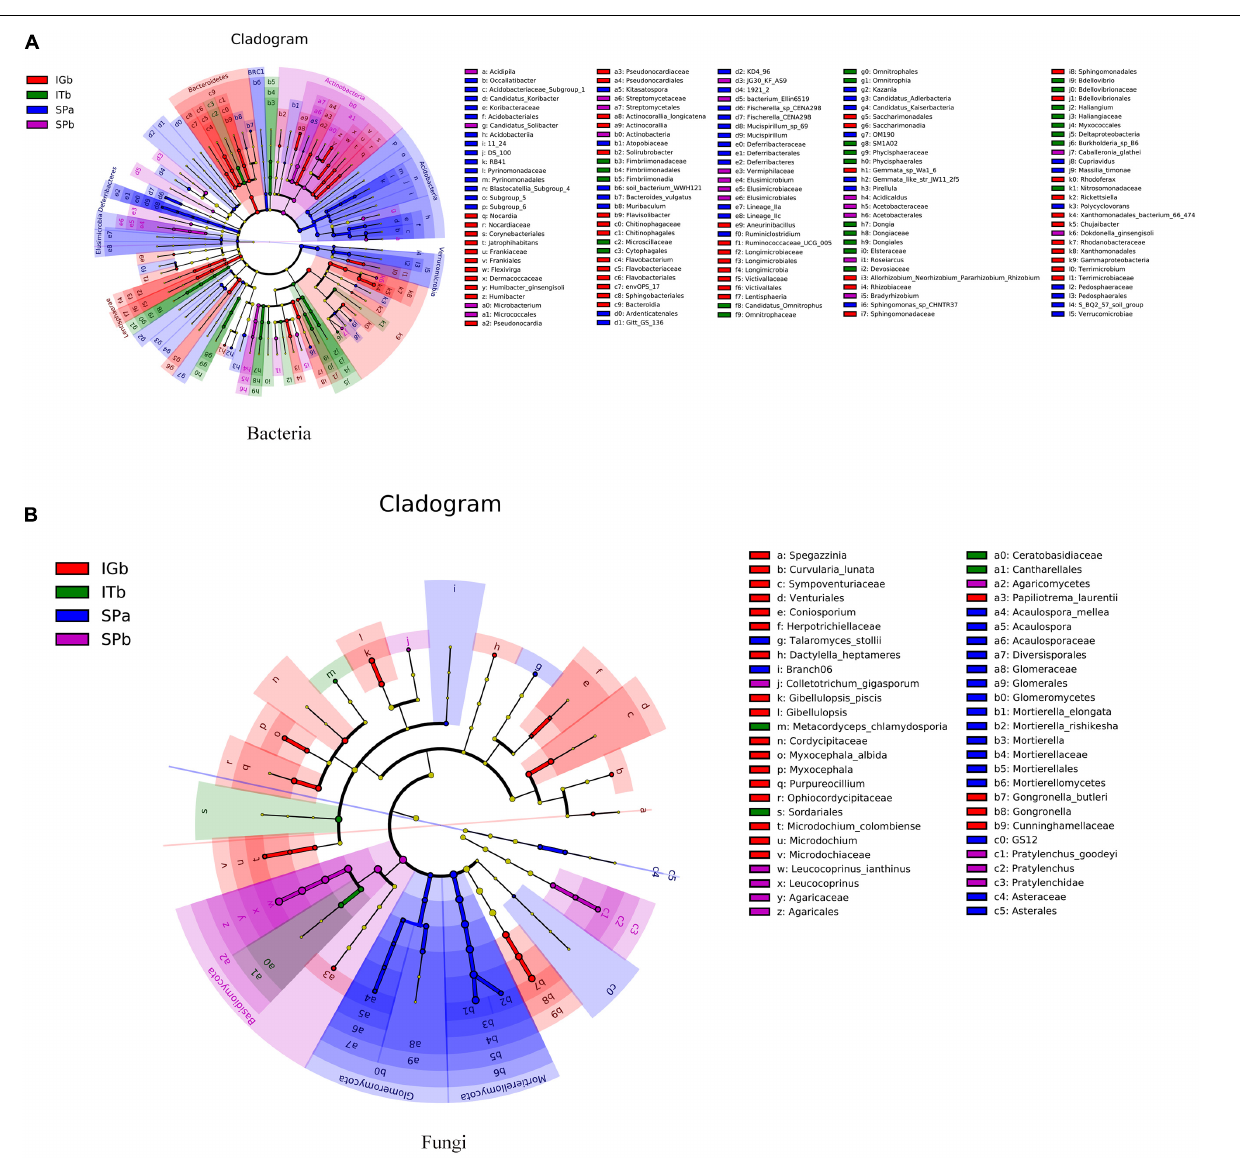
FIGURE 5 | Evolutionary diagrams for the bacteria and fungi when the various planting modes were applied. Each small circle in the figure represents a category at the group level. The inner to outer circles are different categories. In the horizontal classification tree, the diameter of the circle is proportional to the relative abundance. The groups are distinguished by different colors where the colored nodes represent microbial groups that play an important role in the corresponding color group. The yellow nodes represent microbial groups that did not play an important role in any of the treatment groups. (A) Differences in classification levels of bacterial community from phylum to species. (B) Differences in classification levels of fungal community from phylum to